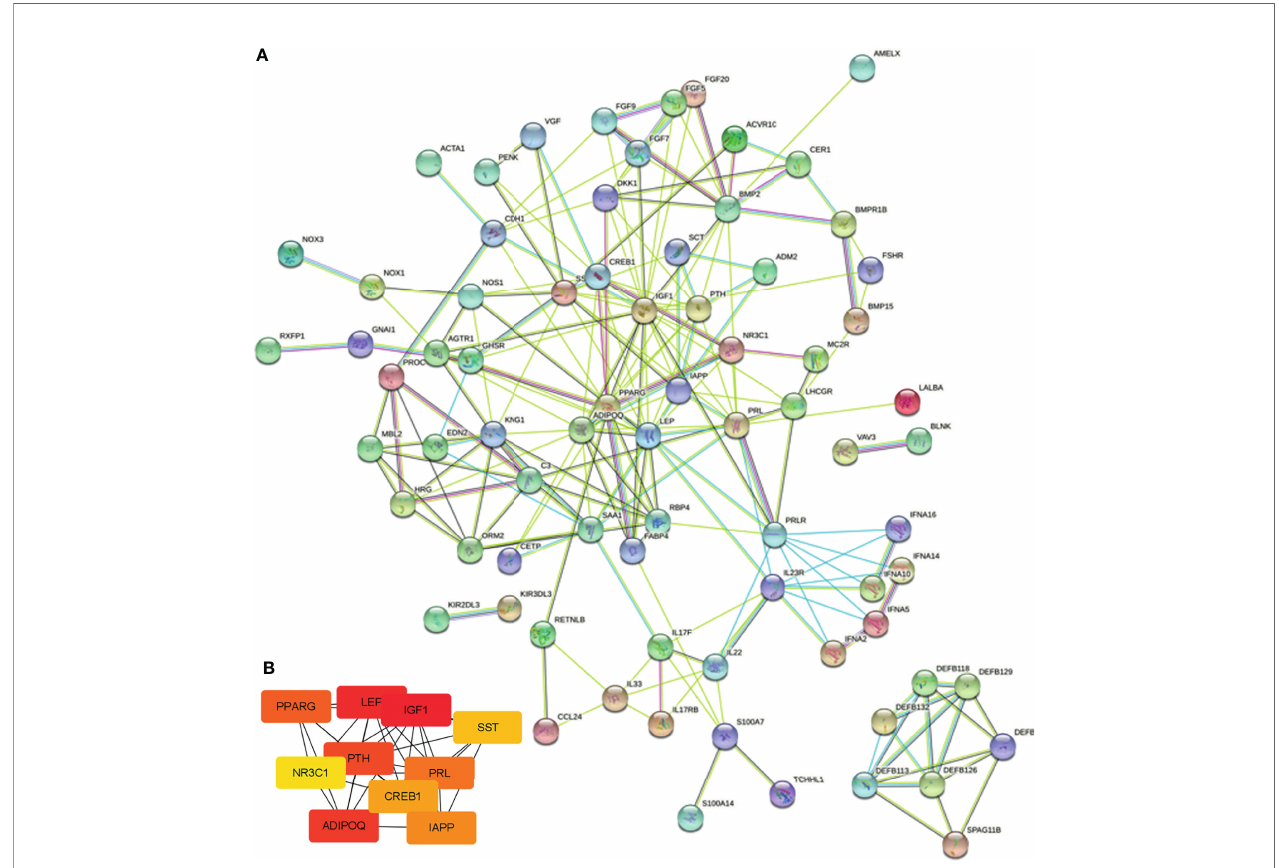
FIGURE 5 | PPI network and hub gene identi fi cation. (A) PPI network was constructed by all the 91 common immune-related DEGs using the STRING database. (B) The top 10 hub genes in the PPI network were screened by Cytoscape plugin